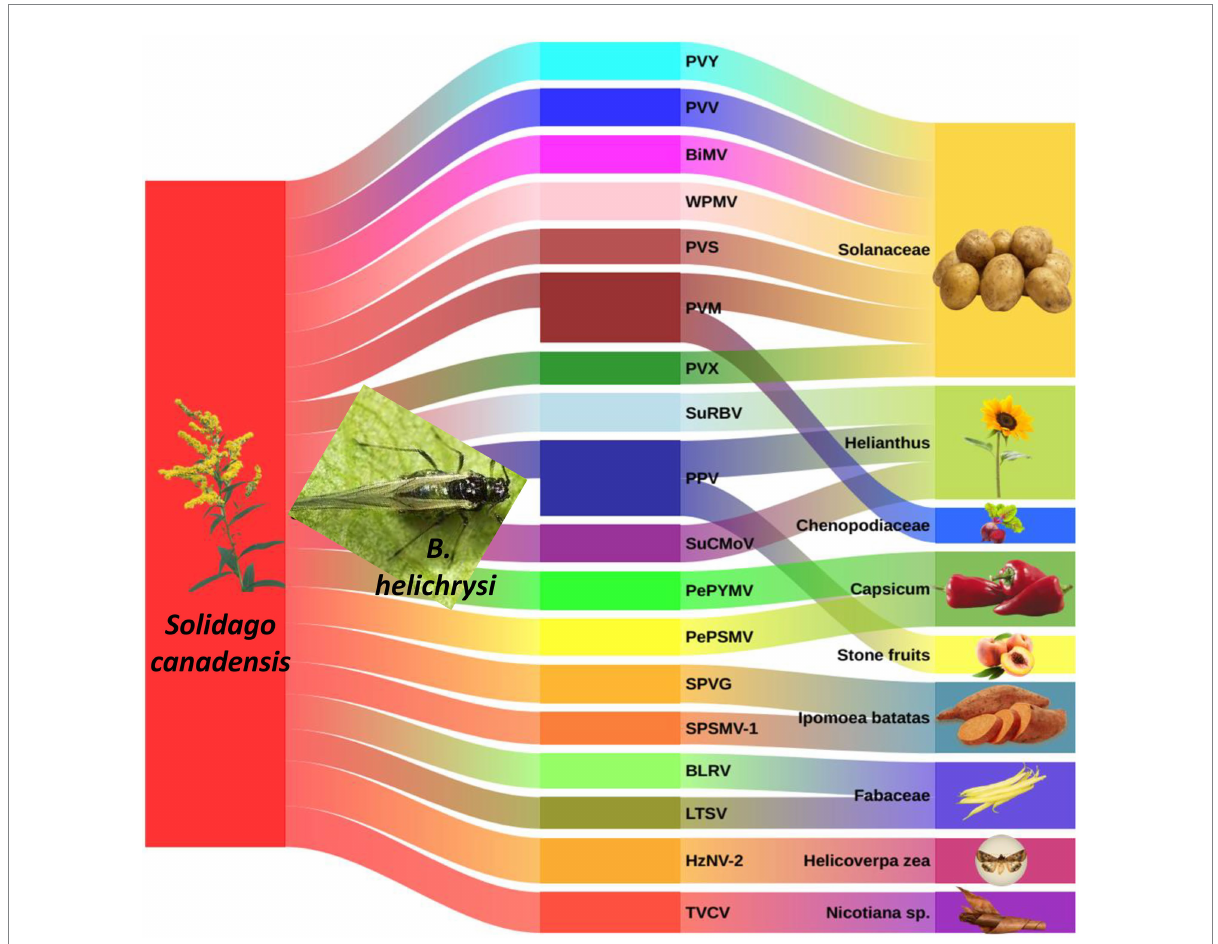
FIGURE 1 Sankey diagram representing direct contact between Canadian goldenrod and crop plants due to plant pathogenic virus transmission via B. helichrysi . To link virus infections with crop plants, data from scientific references were collected and four major factors that influence infections were considered: 1, the same weed-aphid species interactions identified as in our assessments; 2, plant viruses identified in both weed and crop plants using new generation small RNA assessment; 3, virus incidences were observed and were identified as a direct link between weeds and crop plants through aphids; and 4, Management strategies were formulated to control virus infections. The model fits with factors modeling within the DPI (Driving force–Pressure–Impact) framework (Gabrielsen and Bosch,